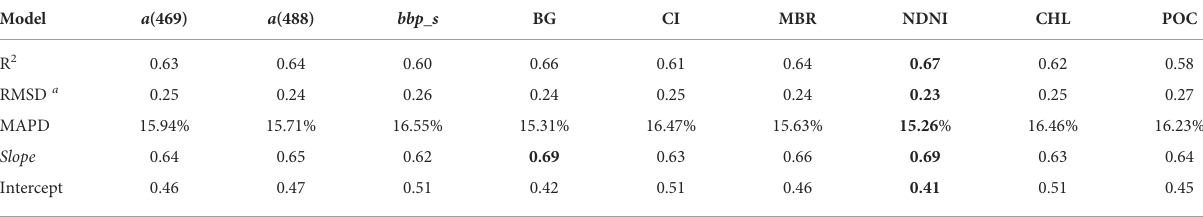
TABLE 4 Statistical descriptions of model validation performance calculated in log10 transformation.